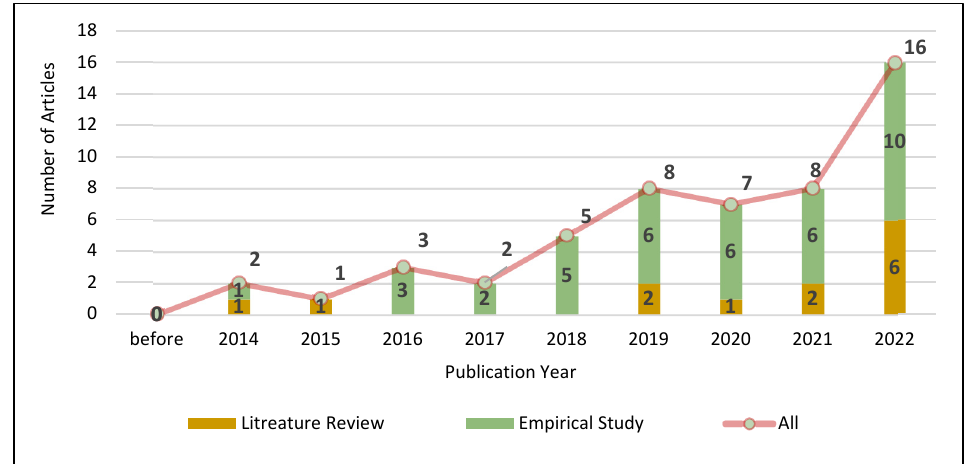
Figure 5. Trends in neuro-tourism research: number of articles by year of publication.